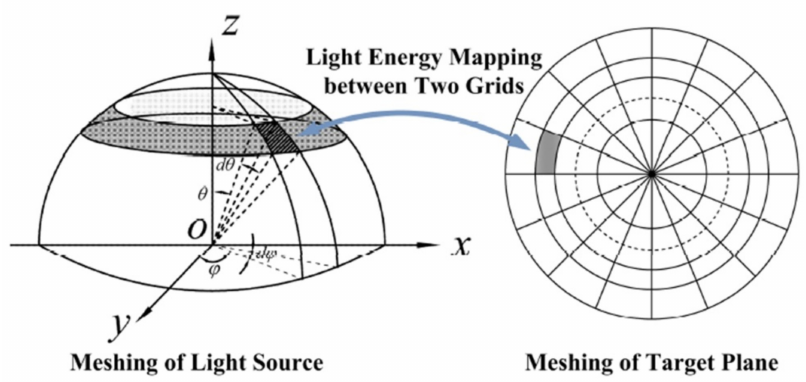
Figure 5. Freeform surface light energy mapping diagram